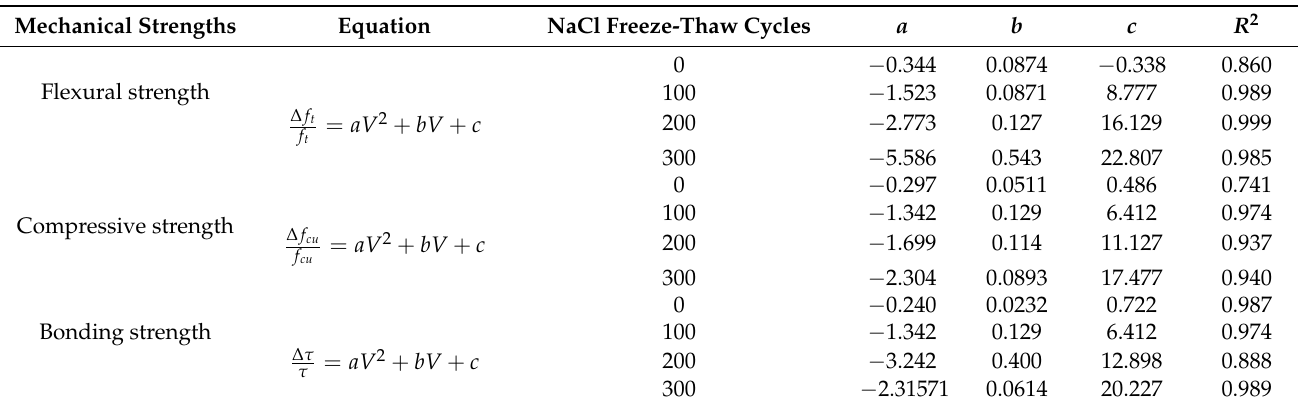
Table 6. The fitting results of mechanical loss rate and the volume of basalt fibers ( V ) under the coupling effect of carbonation and NaCl freeze-thaw